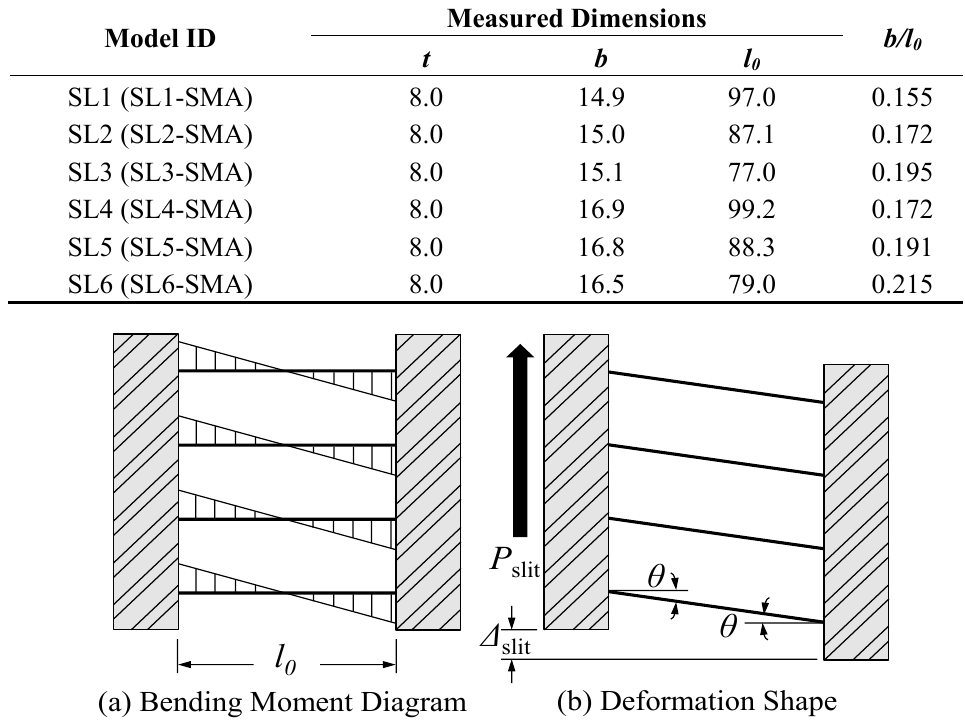
Table 1. Geometric design parameters for experimental slip damper models.